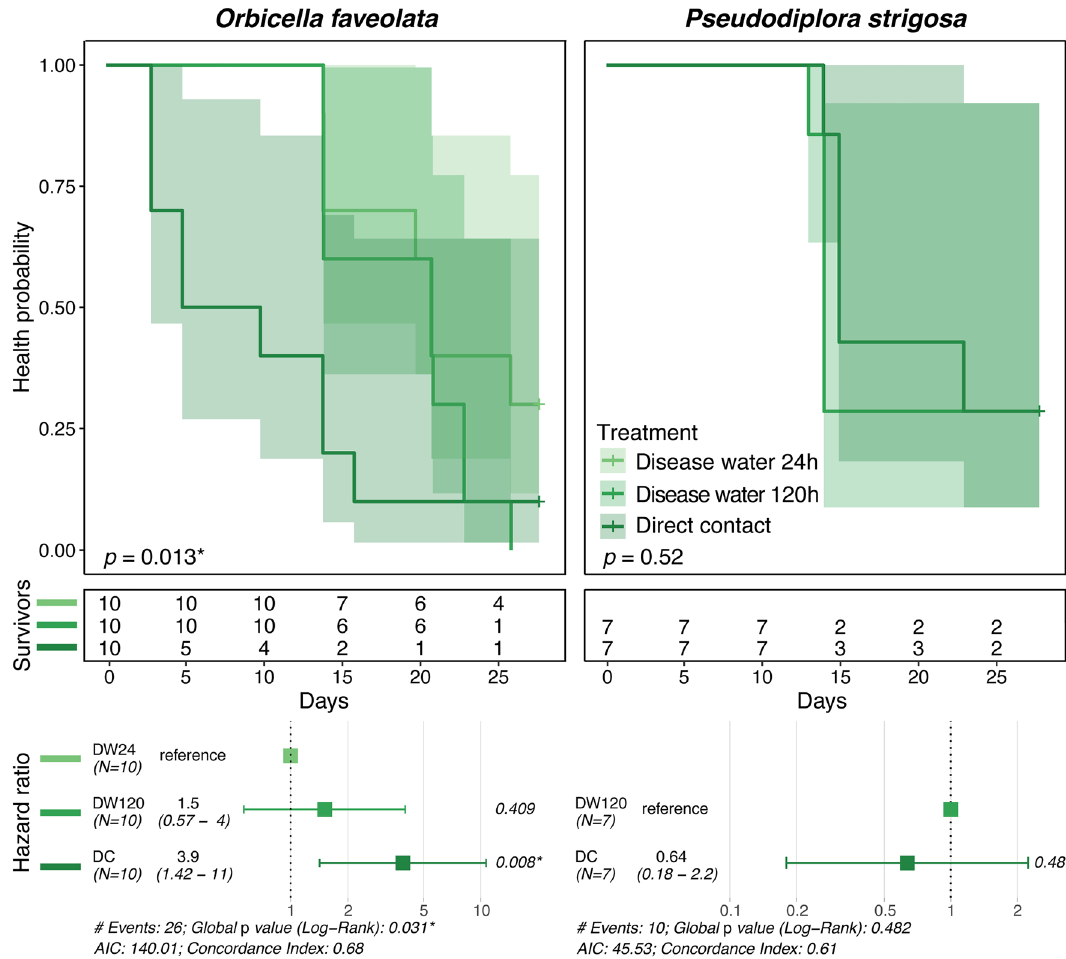
Figure 7. Ballast experiment survivorship curves. Mean time to initial observations of SCTLD lesions and transmission rates (proportion of individuals exhibiting lesions), with survivorship tables and hazard ratio tests of infection risk between treatments. Colors denote treatments, shaded areas denote 95% CI, and test statistics reflect the results of fit proportional hazards regression models for each species. Treatment abbreviations are as follows: disease water 24 h (DW24), disease water 120 h (DW120), diseased coral direct contact (DC), and healthy water 120 h